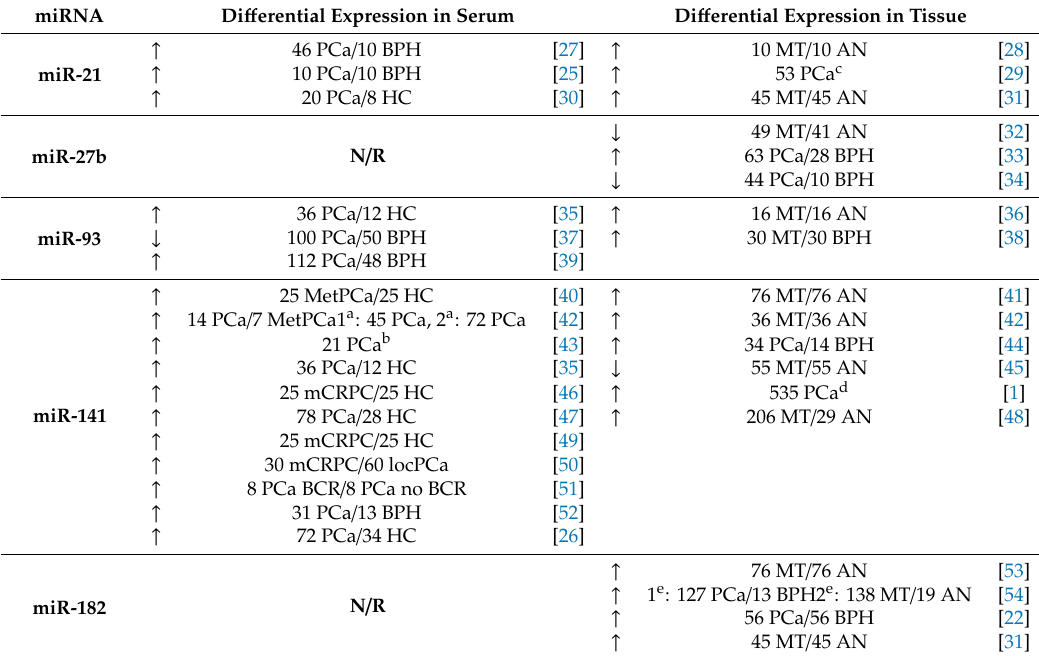
Table 2. Di ff erential expression profile of microRNAs in both serum samples and